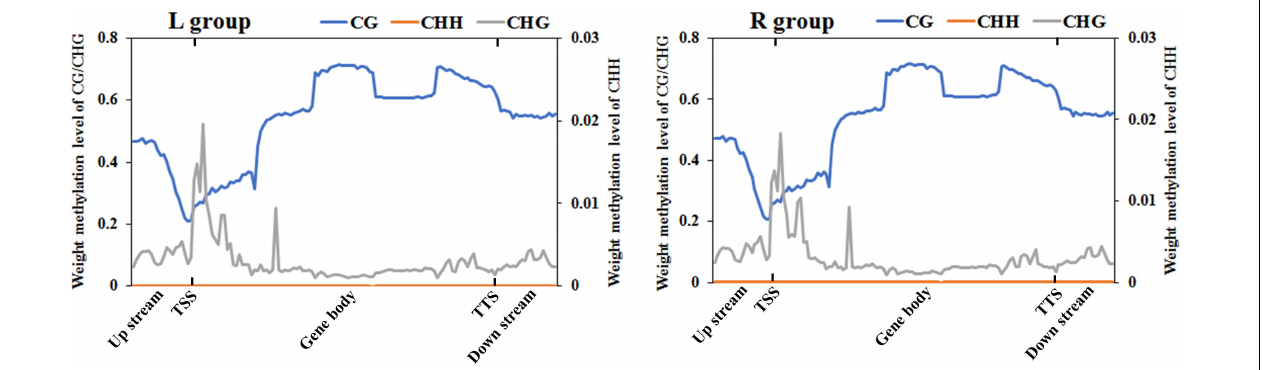
FIGURE 2 | DNA methylation levels across genomic elements in the left-side (affected-side; L) and the right-side (normal-side; R) mandibular condyle of crossed beak chicks with left mandibular curvature. TSS and TTS represents the transcription start site and transcription termination sites, respectively. The blue, origin, and gray solid lines represent CG, CHH, and CHG, respectively.